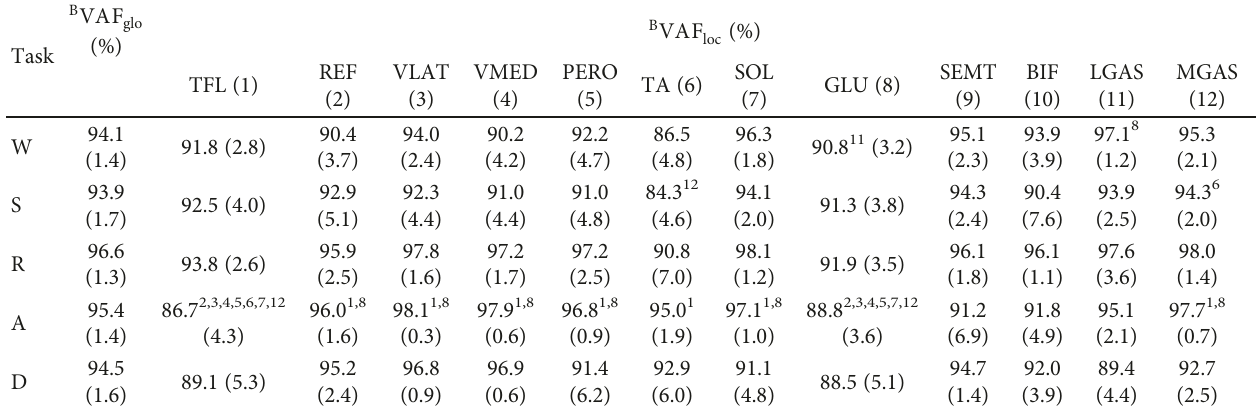
and B VAF related to each task. Di ff erences among muscles are reported glo loc